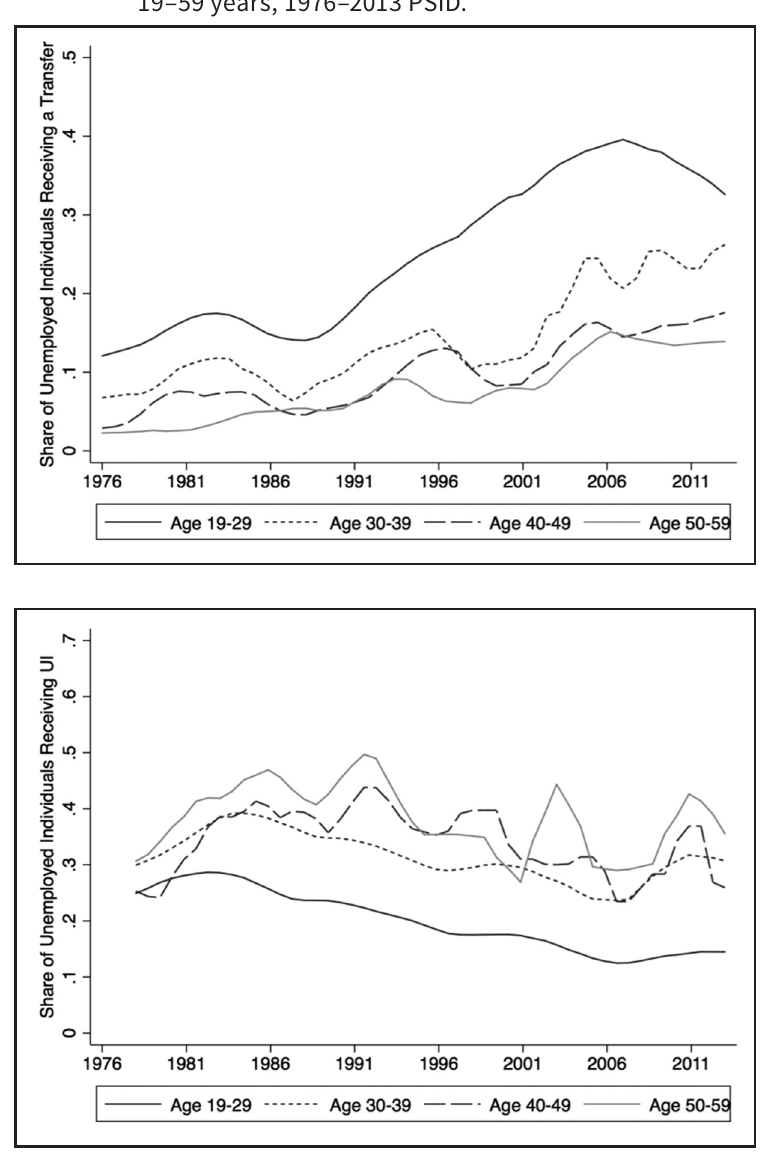
Figure 1 Share of unemployed individuals receiving a transfer from family (top) and unemployment insurance (bottom), heads of household and spouses